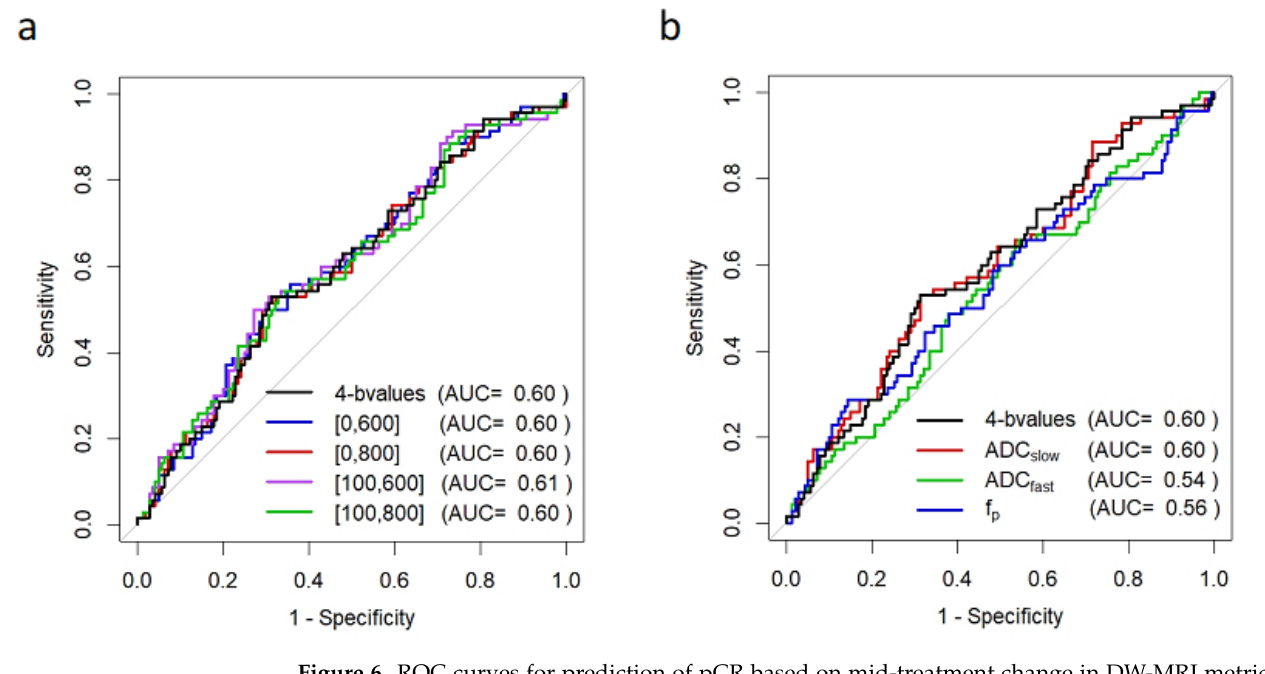
Figure 6. ROC curves for prediction of pCR based on mid-treatment change in DW-MRI metrics. Shown are ROC curves using percent change in ( a ) tumor ADC calculated using alternate b -value combinations of b = 0/600, 0/800, 100/600, and 100/800 s/mm 2 , and ( b ) alternate DW-MRI metrics of ADC fast (using b = 0/100 s/mm 2 ), ADC slow (using b = 100/600/800 s/mm 2 ), and perfusion fraction, f p . Percent change in the reference ADC calculated using all b -values (0/100/600/800 s/mm 2 ) is shown on each plot for comparison (black). Curves reflect data for N = 210 women for all metrics except f p (N = 209; mid-treatment f p could not be accurately calculated in one subject with a very small lesion). Abbreviations: AUC, area under the ROC curve. Table 4. Relative performance of two- versus four- b -value ADC calculations for predicting pCR stratified by cancer